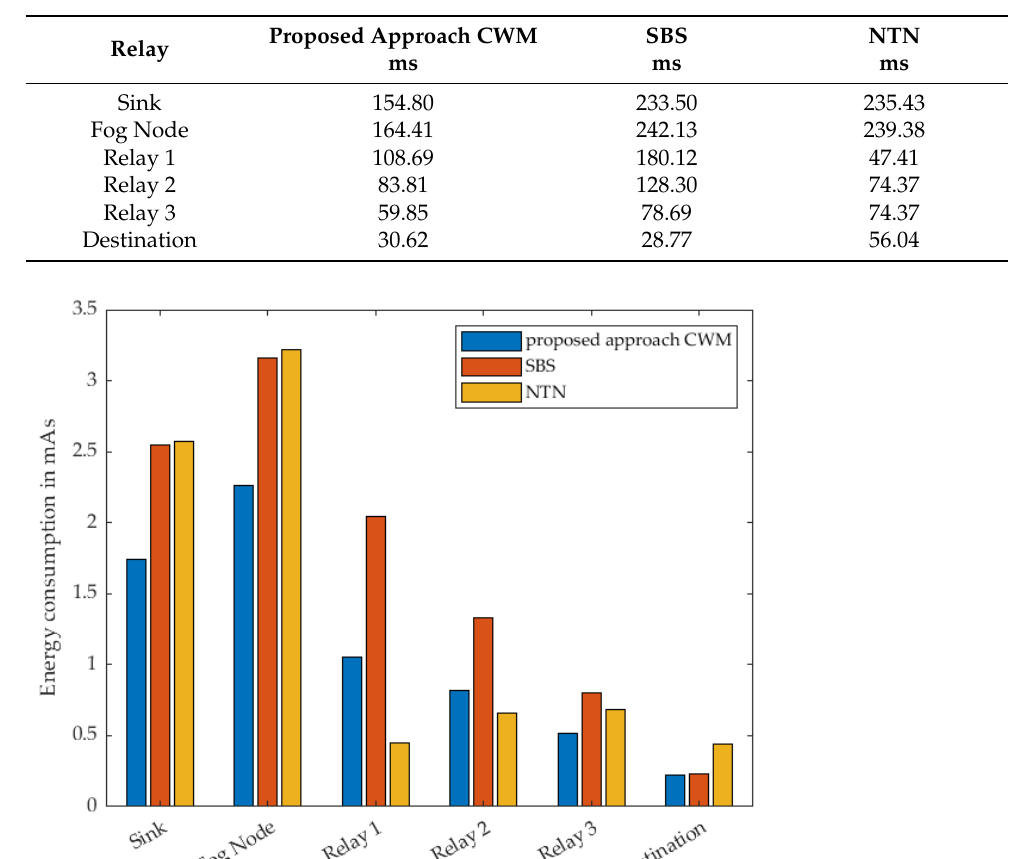
Table 7. Single nodes time in active mode using 3 Relays.